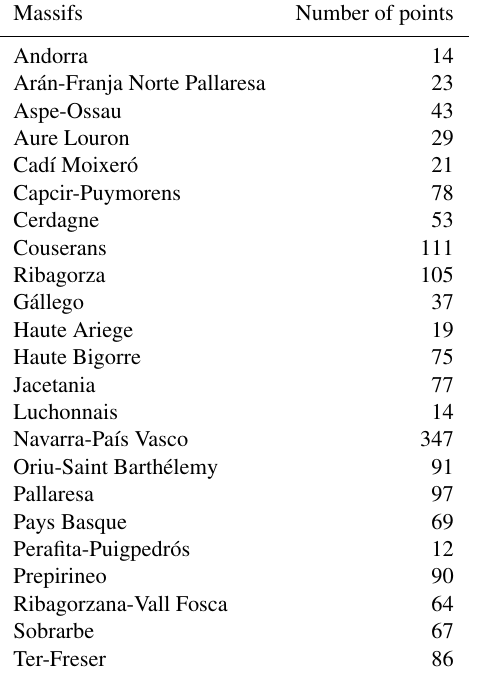
Table 1. Pyrenean massifs and respective number of points. Massifs Number of